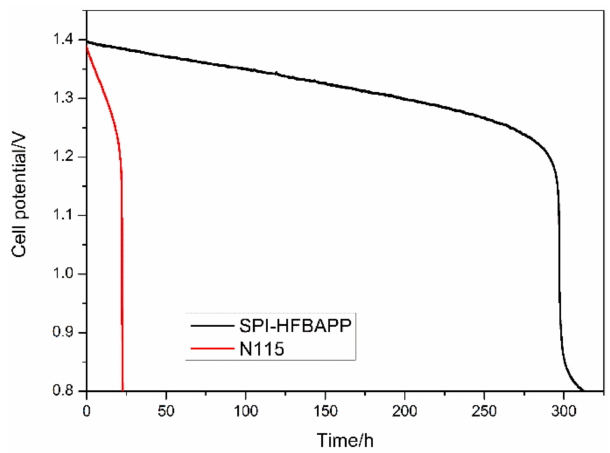
Figure 6. Self-discharge of the VRFB assembled with N115 and SPI-HFBAPP